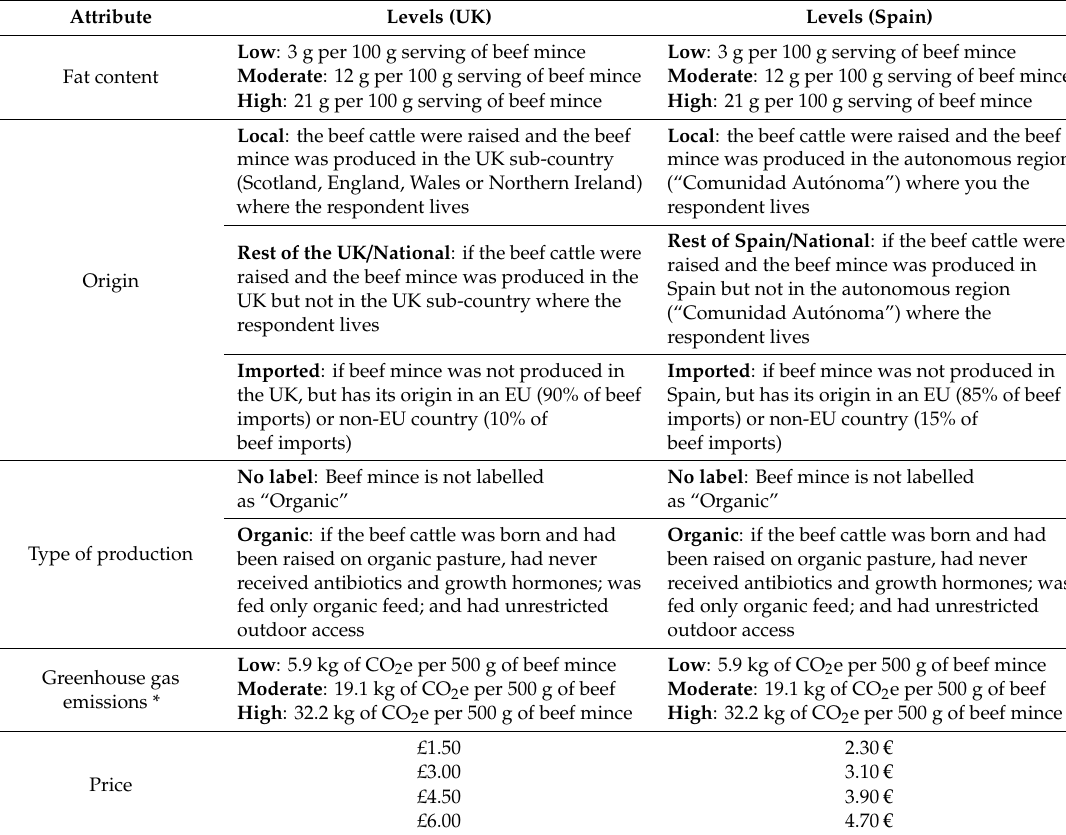
Figure 1. An example of a choice set used in the choice experiment conducted in the UK. Table 2. Attribute levels of beef mince.